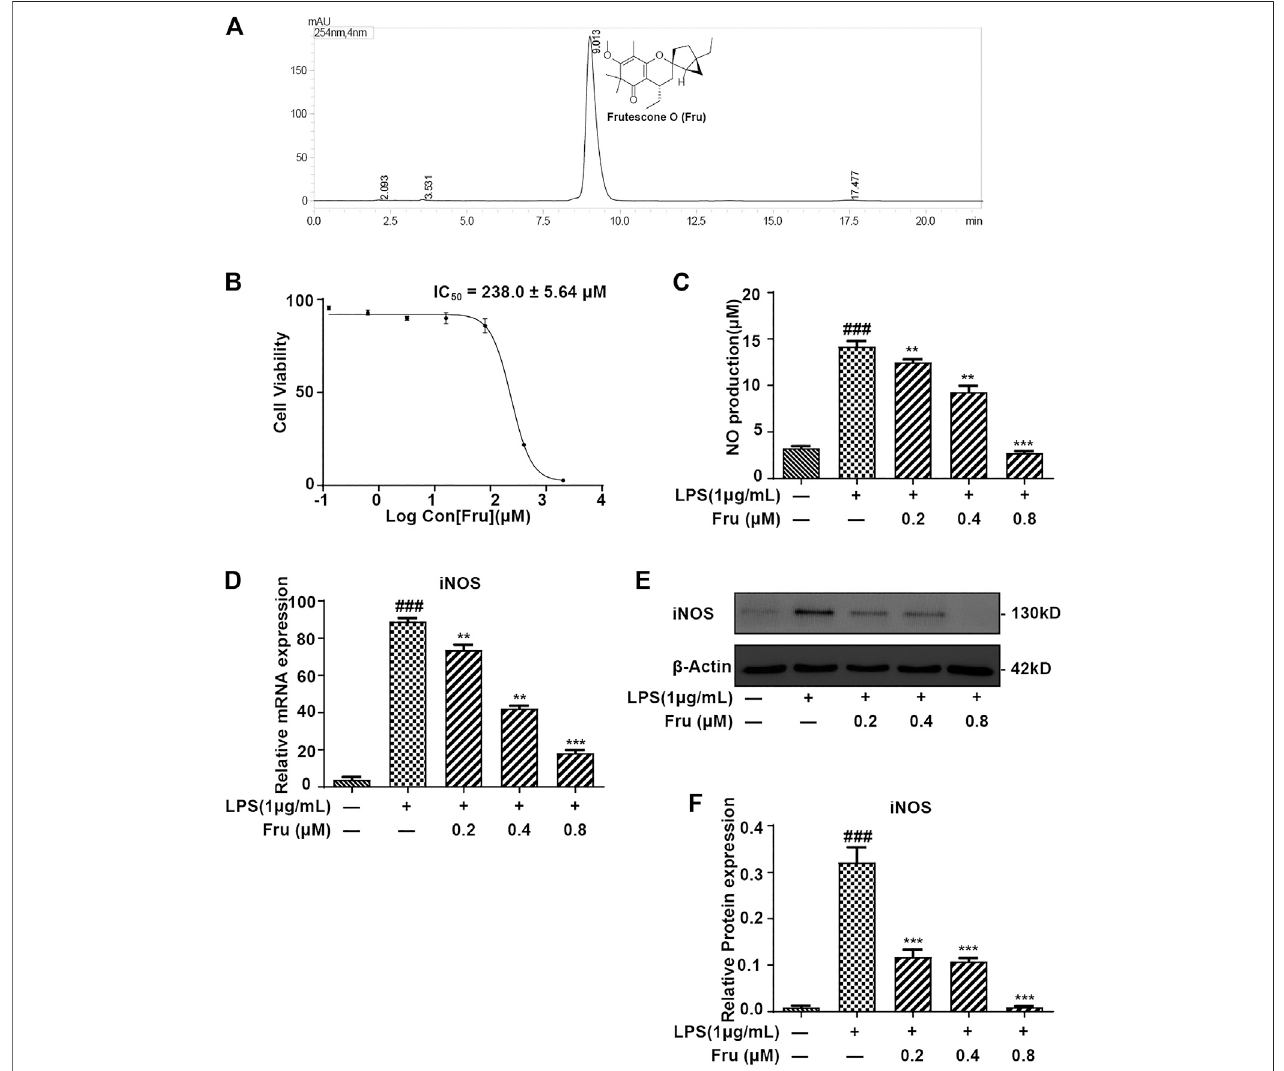
FIGURE1| FrusuppressedtheproductionofNOinLPSinducedRAW264.7cells. (A) StructureandHPLCchromatogramofFruisolatedfrom Baeckeafrutescens L. The purity of Fru was determined to be over 98% by normalization of the peak area detected by HPLC-UV. (B) Effect of Fru on cell viability of RAW264.7 cells. Cells were incubated with Fru (0.1 – 2000 μ M) for 24 h. Cell viability was evaluated by the Alamar Blue assay. (C) Fru suppressed the production of NO in LPS-induced RAW264.7 cells. Cells were incubated with different concentrations of Fru (0.2, 0.4, and 0.8 μ M) and 1 μ g/ml LPS for 18 h. NO production in the cell culture supernatant was detected by the Griess assay. (D) Effect of Fru on iNOS mRNA expression. Relative mRNA expression levels of iNOS were measured with qRT-PCR andnormalizedtoGAPDH. (E,F) EffectsofFruoniNOSproteinexpression.TheexpressionofiNOSwasdeterminedwithWesternBlotanalysis. β -actinwasusedasthe internal control. Quantitative data was represented as mean ± SD ( n (cid:2) 3, ### p < 0.001 vs. Control; ** p < 0.01, *** p < 0.001 vs. LPS).